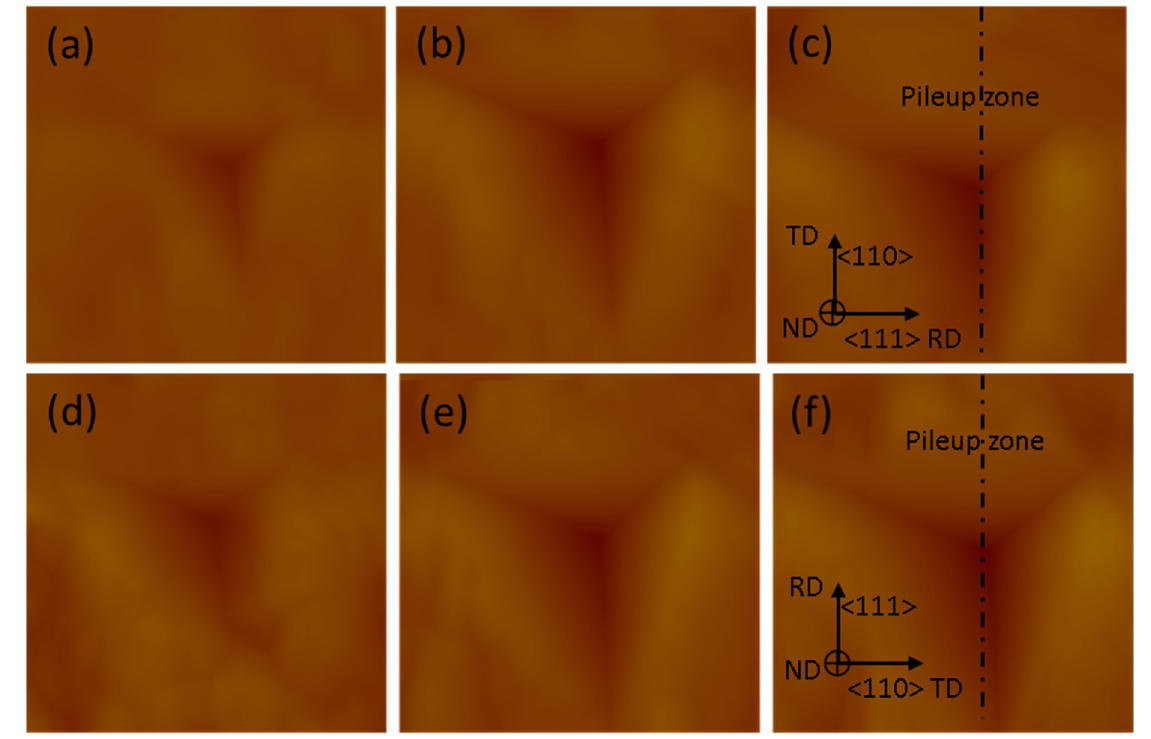
Figure 5. Figure shows scanning probe microscopy (SPM) images of the indentations performed along either the TD or RD of a Cu(16)/Nb(16) ARB nanolaminate. The indention depths were ( a ) 200 nm, ( b ) 300 nm and ( c ) 400 nm for TD and ( d ) 200 nm, ( e ) 300 nm and ( f ) 400 nm for RD. The SPM images with scanned area 3 × 3 μ m 2 were attained after nanoindentation to precisely plot the height profiles along the major axis of indents revealed by the dashed line, and later the corresponding pile-up heights were obtained. Crystallographic directions are specified for Cu.